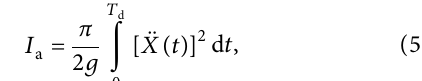
p to the pulse intensity PI